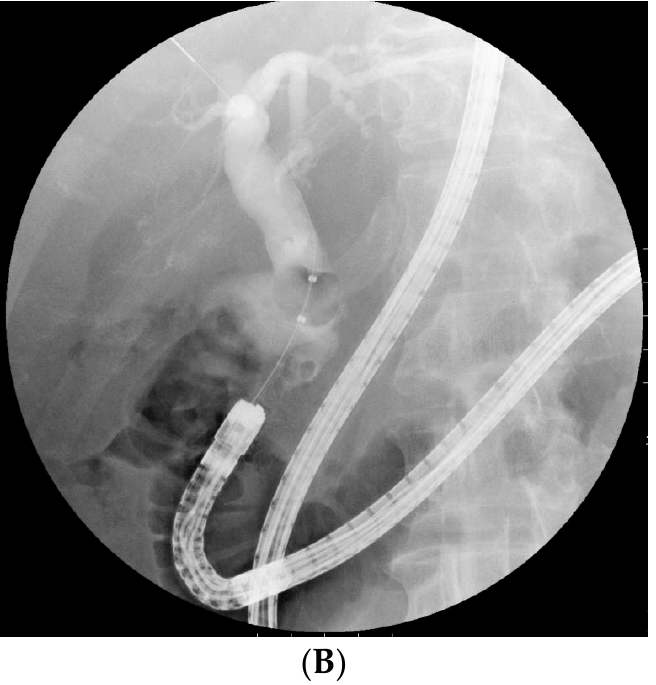
Figure 1. A useful “retroflex position” for stone extraction in a Roux-en-Y gastrectomy patient. ( A ) At the initial session, the scope was stretched after reaching the papilla (not formed the retroflex position). Following successful biliary cannulation, precutting, and endoscopic papillary large balloon dilation, a stone was able to be grabbed with a mechanical lithotripter. However, complete stone extraction was not able to be conducted using any devices, including a basket catheter or balloon catheter,